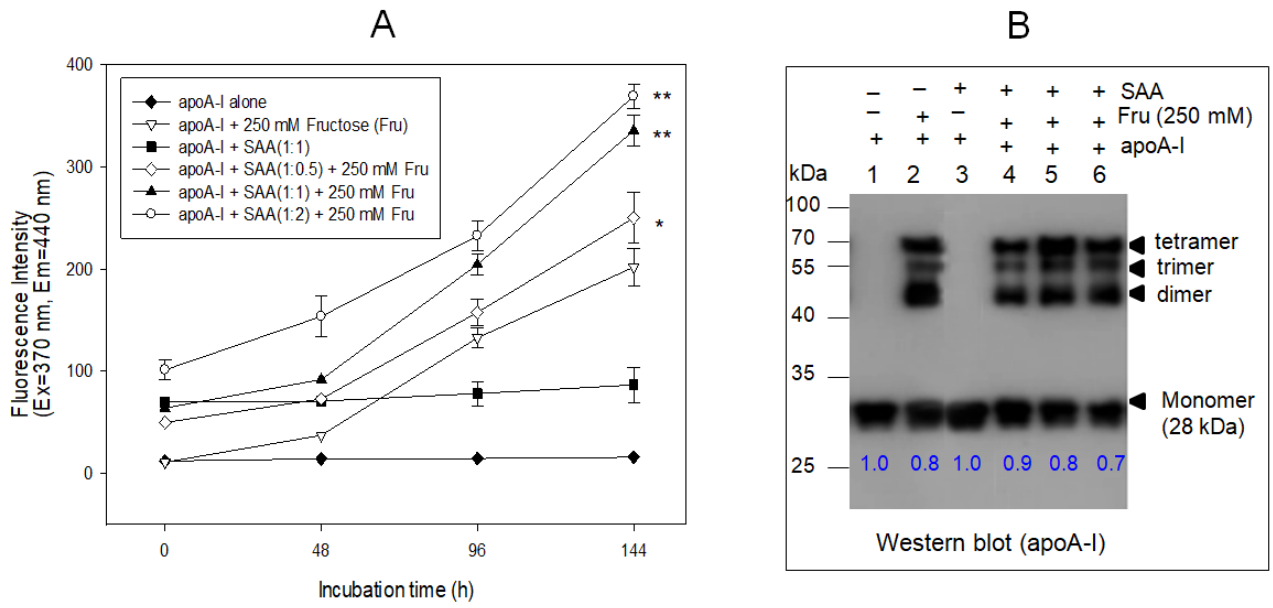
Figure 6. Glycation of apoA-I and SAA by fructose (Fru, final 250 mM) treatment. ( A ) Fluorospec- troscopic determination of advanced glycated end product (Ex = 370 nm, Em = 440 nm). * p < 0.05 versus apoA-I + Fru; ** p < 0.01 versus apoA-I + Fru. ( B ) Immunodetection of native or glycated apoA-I, SAA, and their mixture. Lane 1, apoA-I alone; lane 2, apoA-I + Fru; lane 3, apoA-I + SAA; lane 4, apoA-I + SAA (1:0.5) + Fru; lane 5, apoA-I + SAA (1:1) + Fru; lane 6, apoA-I + SAA (1:2) + Fru. The blue numbers in the photograph indicate the band intensities (BI) of each apoA-I band. The BI was compared by band scanning with Chemi-Doc ® XR (Bio-Rad, Hercules, CA, USA) using Quantity One software (version 4.5.2) from three independent